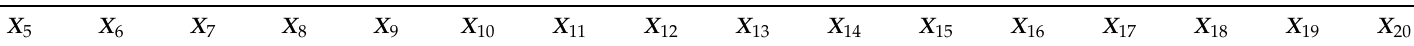
Table A2. Analysis of interaction effects of urban service-land area in